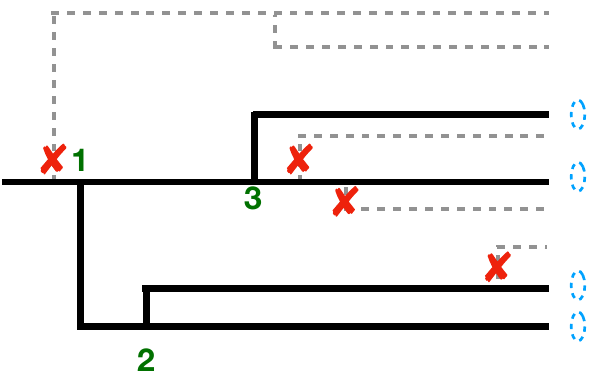
Figure 2. Schematic depiction of the RSD N algorithm, where a C/A clustering tree is declustered until eq. (2.1) is satis(cid:12)ed N times. For N (cid:20) 3, the grooming stops at the numbered branch N , such that N = 1 corresponds to the original SD algorithm. The grooming of all dashed gray lines is achieved for N >